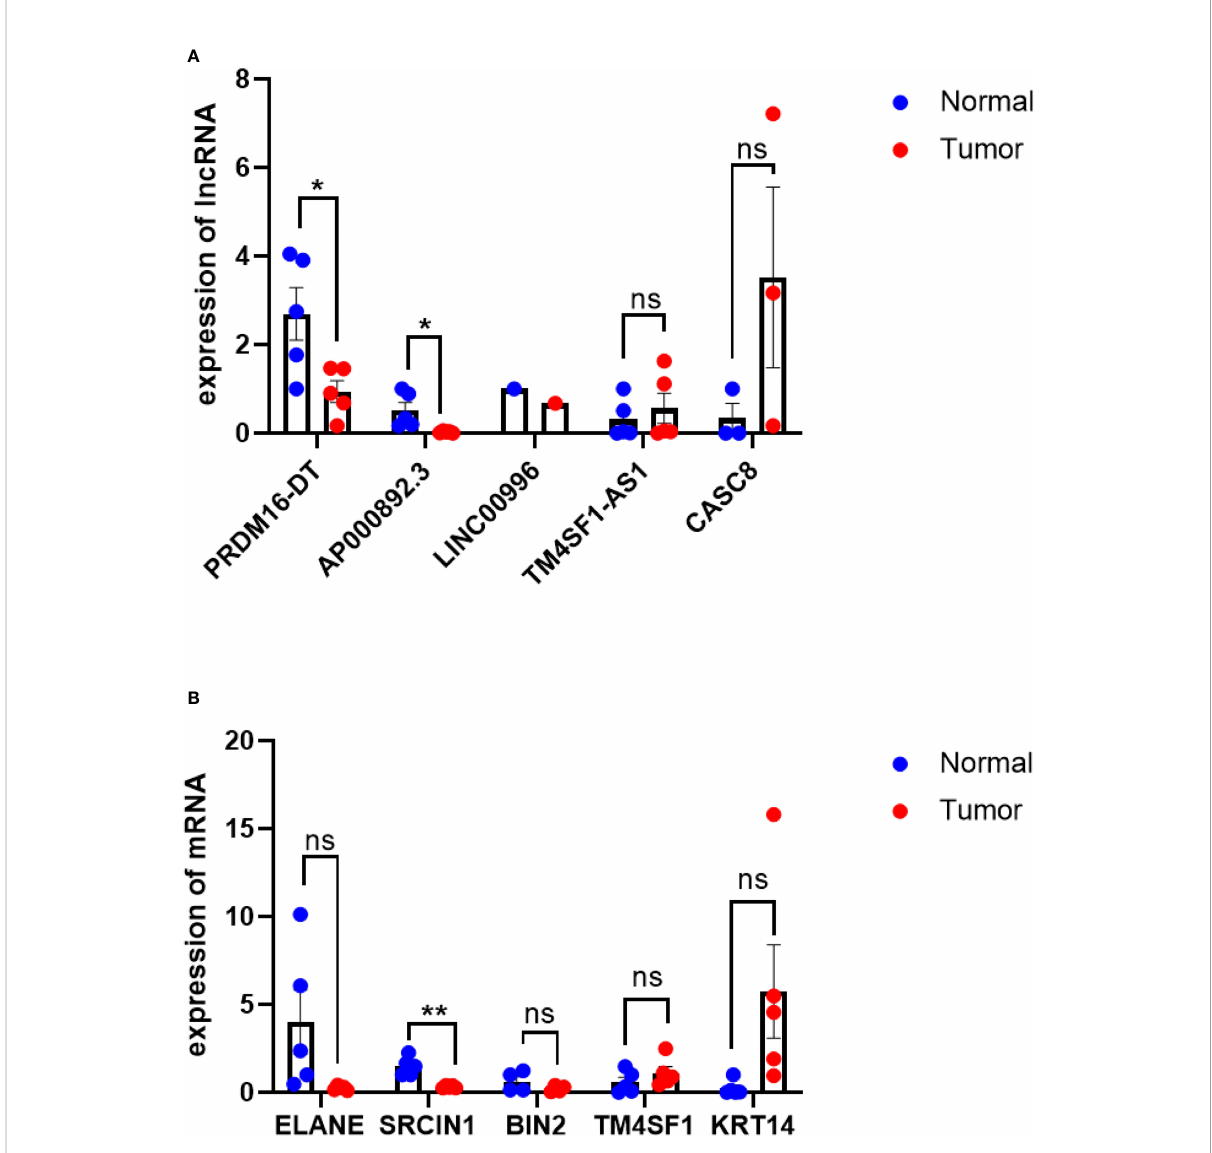
FIGURE 8 qRT-PCR of lncRNAs and their target genes. (A) qRT-PCR results of lncRNAs, PDAC tissue VS normal tissue. (B) qRT-PCR results of target genes, KRT14 is highly expressed in PDAC tissues(p=0.07), ELANE expression is lower in normal tissues(P=0.07), PDAC tissue VS normal tissue. *P< 0.05, **P< 0.01; Ns, not signi fi